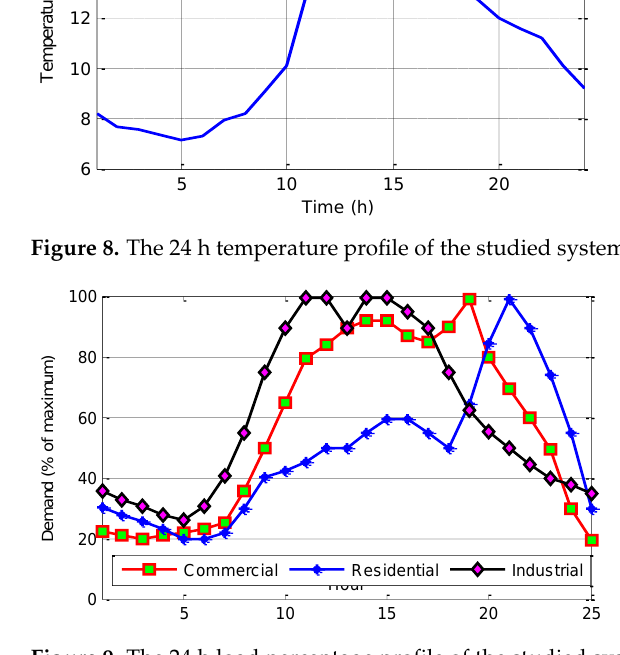
Figure 9. The 24 h load percentage profile of the studied system. Table 1. Type of load and power values for modeling.